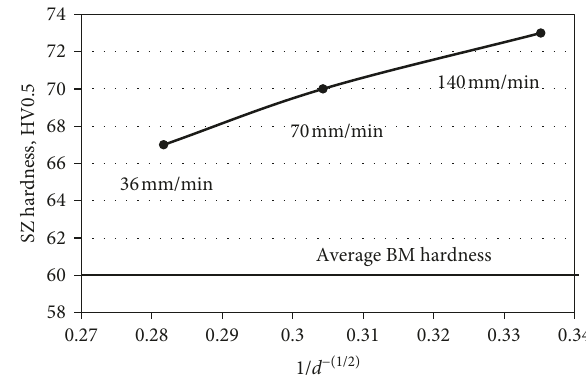
Figure 13: The relation between average SZ hardness and average SZ grain size according to the Hall–Petch relation. Note: the horizontal line represents the average hardness of the